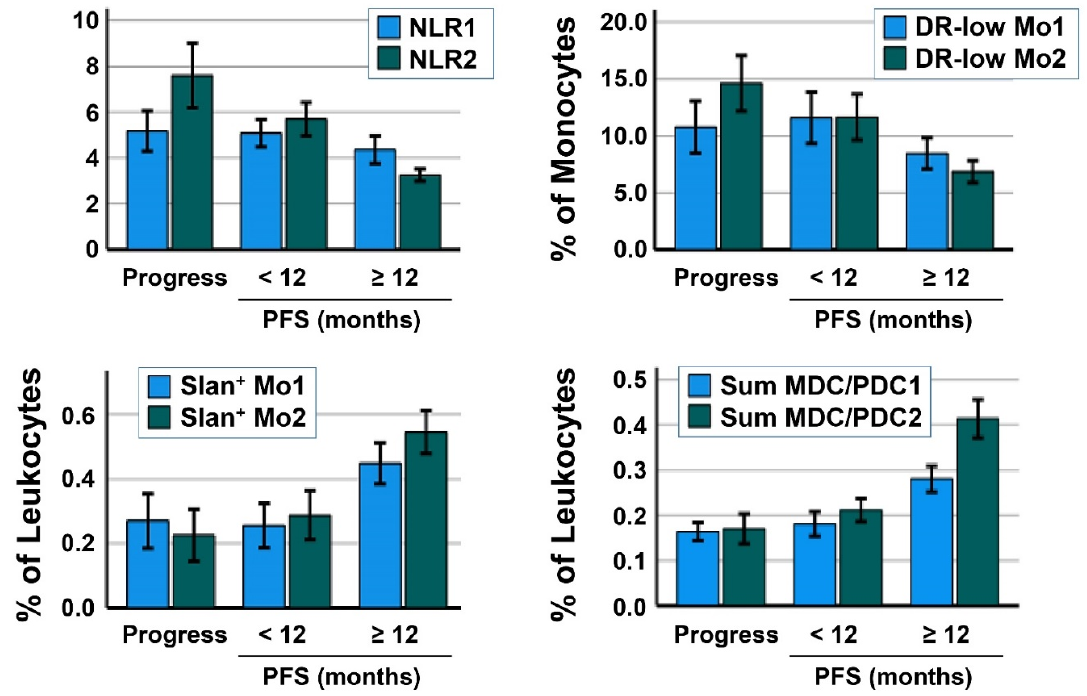
Figure 1. Correlation of blood immune cell markers in the patients’ groups progression/therapy discontinuation, PFS <12 months und PFS ≥ 12 months overtime (baseline values as 1, ICI-third cycle values as 2). Mean values and error bars are displayed regarding the NLR, the amount of HLA-DR low MDSC (% of monocytes), the percentage of slan+ non-classical monocytes (% of leukocytes), and the sum of MDC/PDC (% of leukocytes).